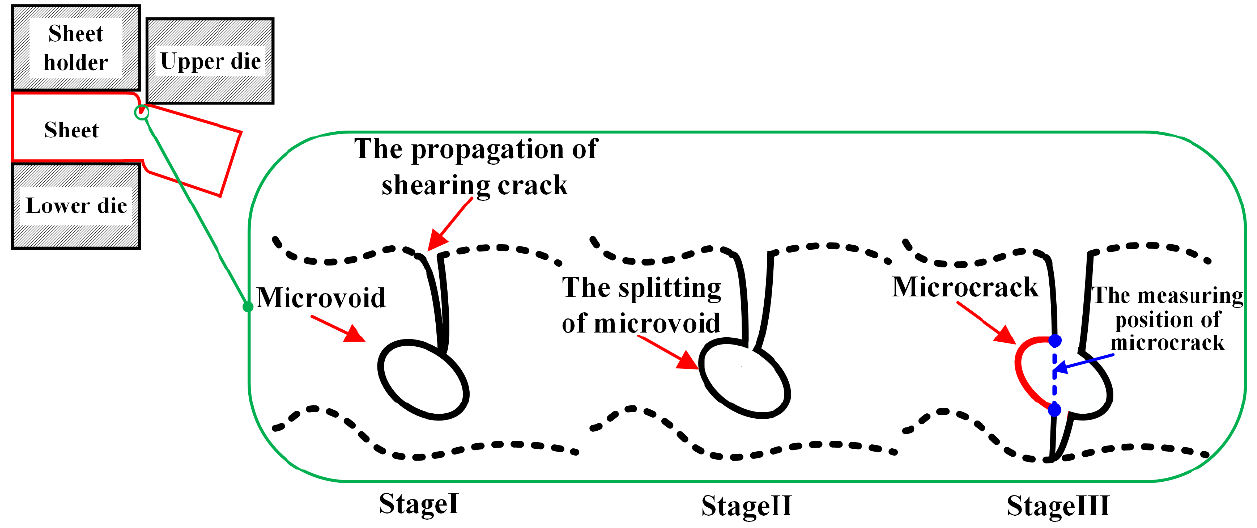
Figure 19. Process of microcrack